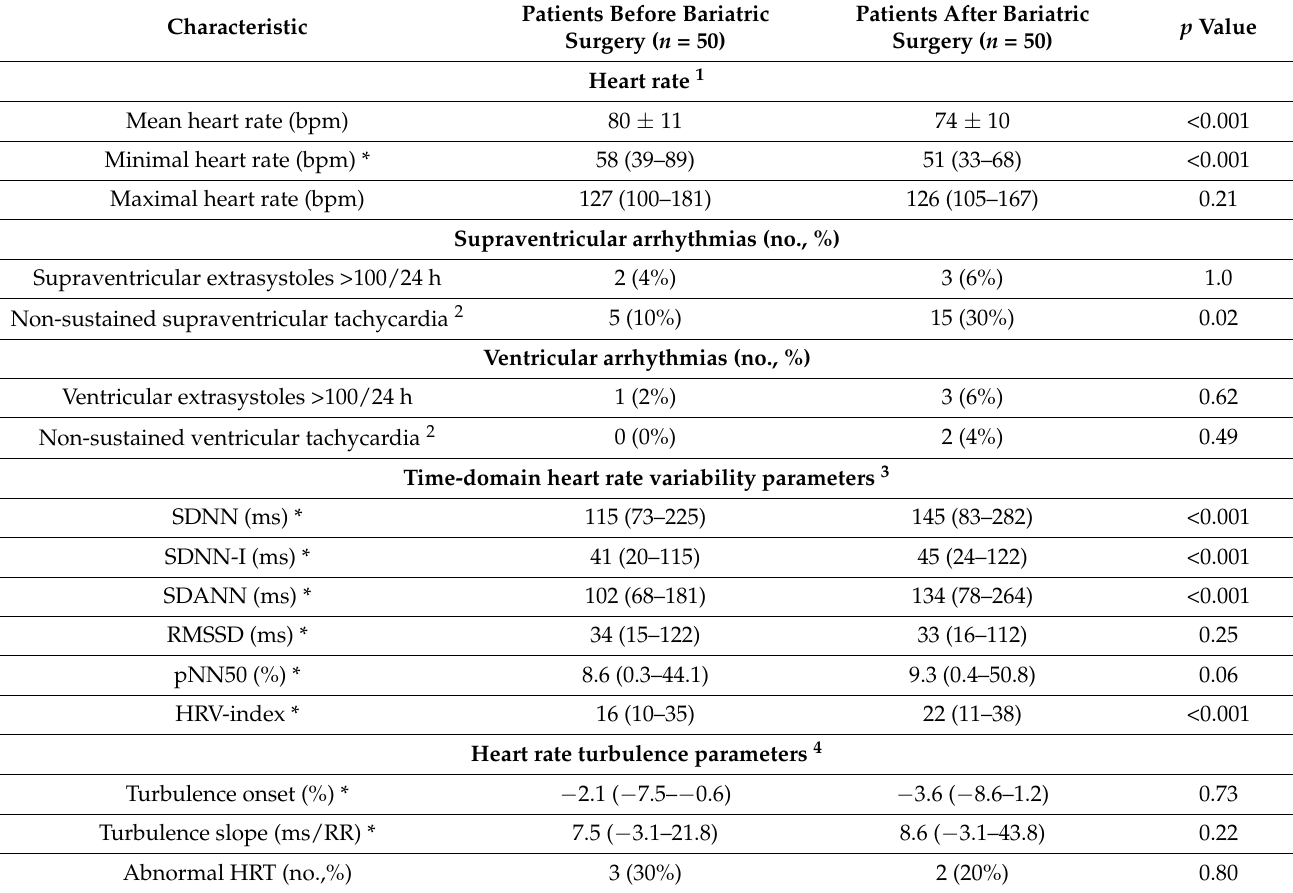
Table 1. Arrhythmias and heart rate variability parameters in 24-h Holter monitoring in patients before and after bariatric surgery. Characteristic